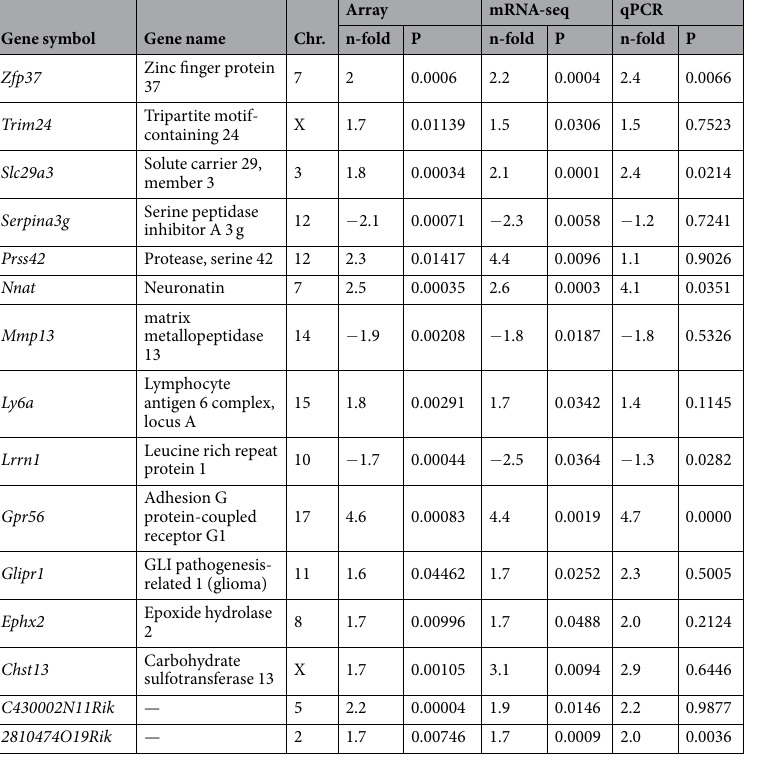
Table 1. Differentially expressed genes in Kdm4b -overexpressing MEFs. Chr. = chromosome, ND = not